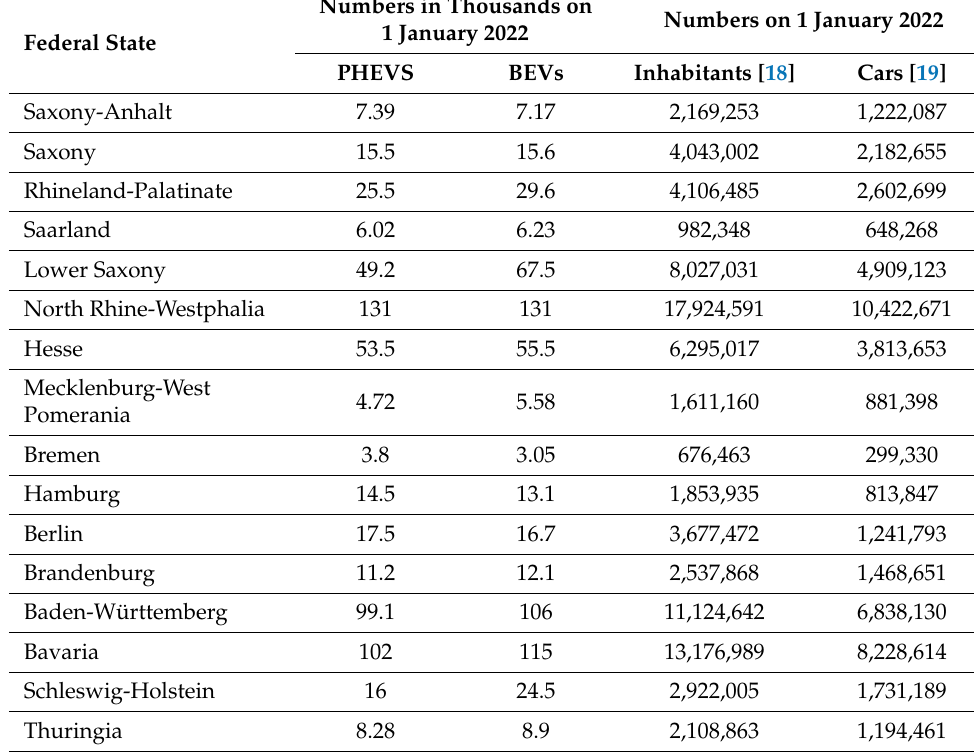
Figure 2. Estimated battery energy of the EV fleet over time split by BEVs and PHEVs. The dark- blue line is the estimated central value. The surrounding light-blue lines are the error corridor that results from the fact that the national car registry’s identification system does not differentiate between the battery energy difference of different versions of a car model.